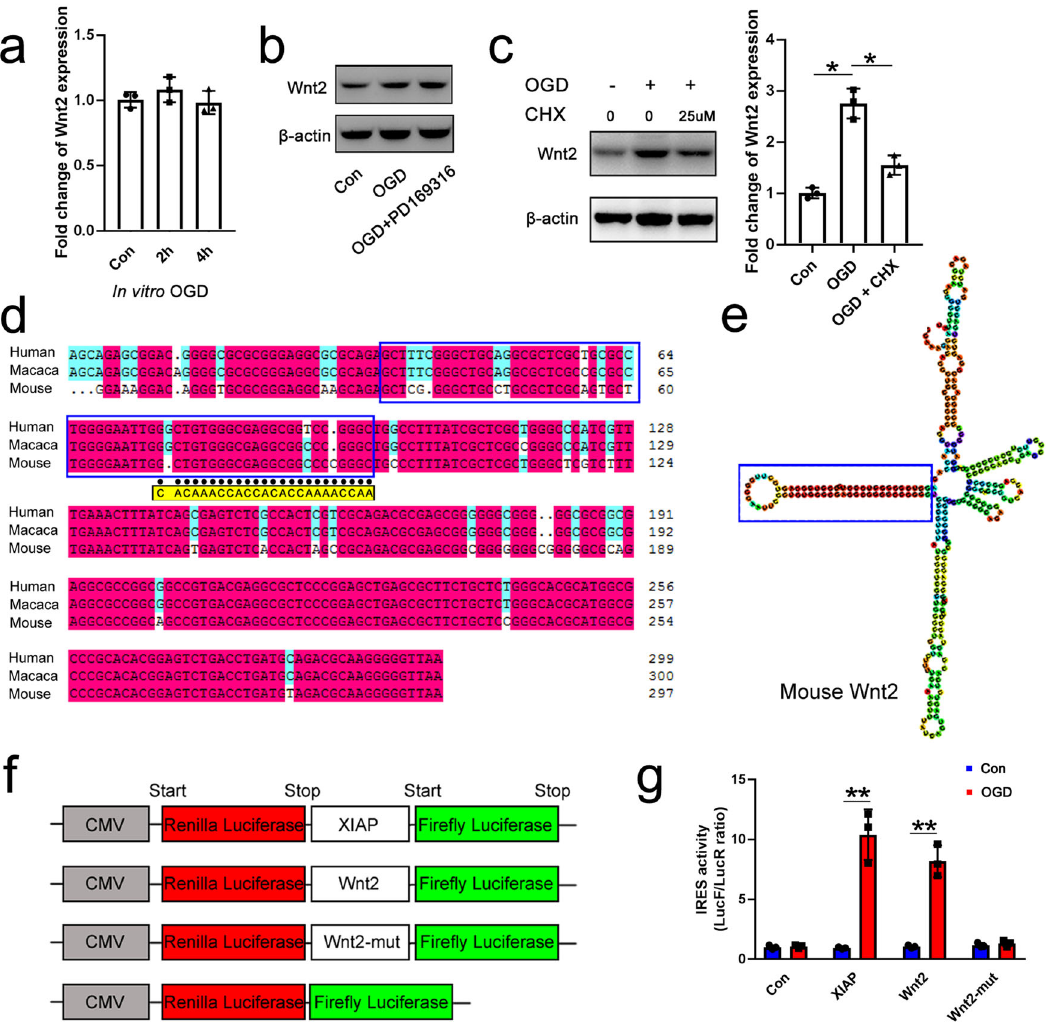
Fig. 9 IRES-mediated Wnt2 protein translation. a Real time RT-PCR of Wnt2 in OGD treated neurons. b Western-blotting of Wnt2 in apoptotic neurons treated with PD169316. N = 3 batches of cells. c Western-blotting and quanti fi cation of Wnt2 in apoptotic neurons treated with CHX. Notice that OGD does not induce Wnt2 mRNA transcription and that CHX blocks OGD-induced Wnt2 protein up-regulation. * P con vs = 0.011, * P = 0.031. One-way ANOVA followed by Bonferroni ’ s post hoc comparisons tests. N = 3 batches of cells. OGD OGD VS OGD + CHX d Sequence alignment of mouse, Macaca Mulatta and human Wnt2-5UTR. e Secondary structure of mouse Wnt2-5UTR. Blue frames in ( d ) and ( e ) show the largest stem-loop and the corresponding sequence. The sequence underlined by black dots (in d ) was replaced by the sequence below highlighted with yellow color to make Wnt2-5UTR mutant construct in ( f ). f , g Bicistronic luciferase reporter assay of XIAP-5UTR, Wnt2- 5UTR, and Wnt2-5UTR mutant under control and OGD condition. ** P XIAP = 0.0022, ** P Wnt2 = 0.0019. One-way ANOVA followed by Bonferroni ’ s post hoc comparisons tests. N = 3 batches of cells. Notice that Wnt2-5UTR initiates OGD-induced Wnt2 translation and mutation at the largest loop abolishes this translation. Mean ± standard error (SE). Asterisks with bars connecting two groups indicate difference between these two